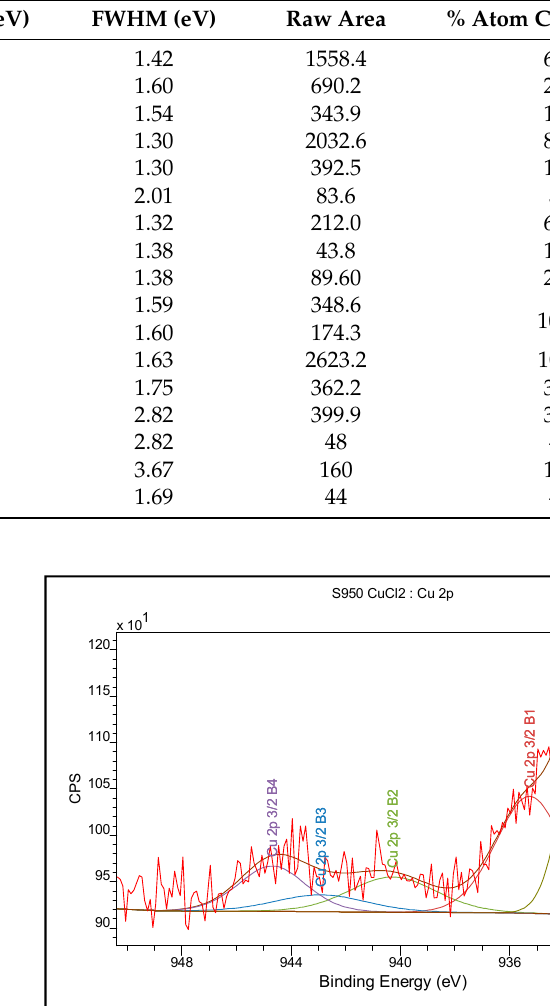
Table 9. The XPS analysis results obtained in the narrow range of binding energy for Purolite S 950 after sorption of Cu(II) ions.